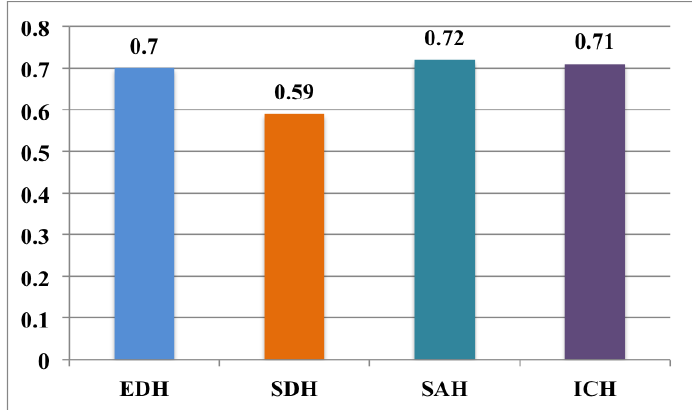
Figure 16. Average precision (AP) of four brain hemorrhage